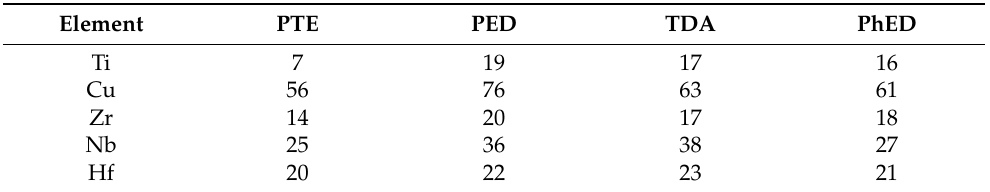
Table 4. The recovery of Ti, Cu, Zr, Nb and Hf from SmCo-solutions, %. Sorption conditions: without